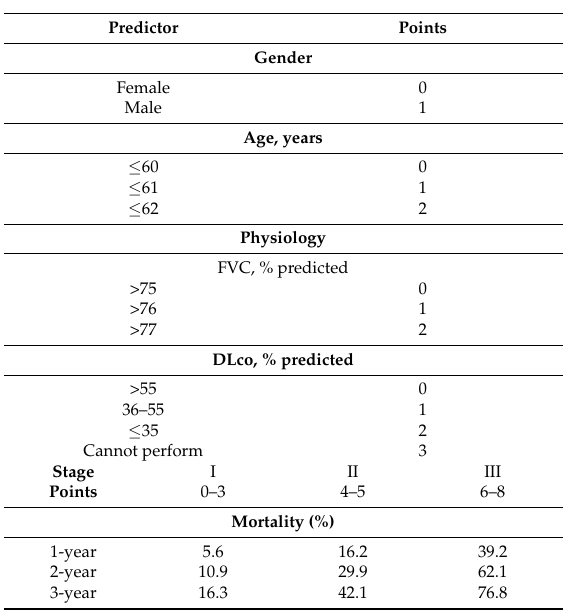
Table 4. Gender, Age, Physiology (GAP) Index.